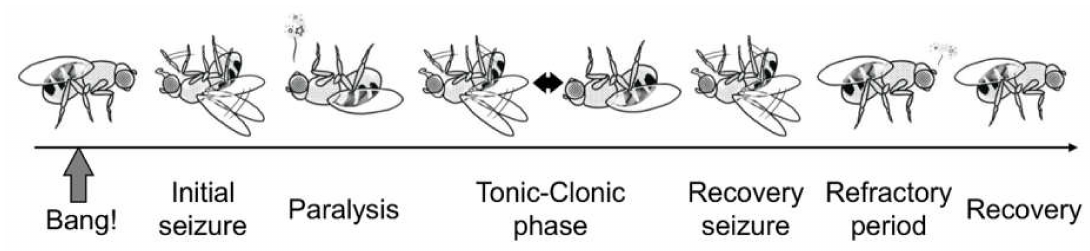
Figure 2. Drosophila “bang-sensitive”